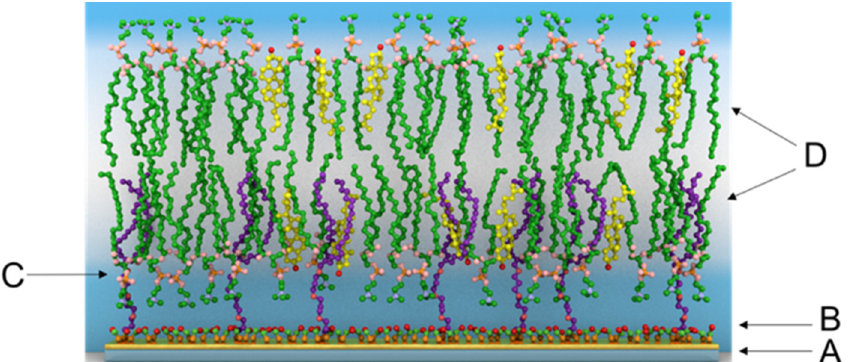
Figure 2. Illustration of the tBLM: A , Au-monolayer coated glass slide; B , β -mercaptoethanol; C , Anchor molecule; D , phospholipid bilayer. Mixed SAM defines an ionic reservoir between the gold and the bilayer membrane .